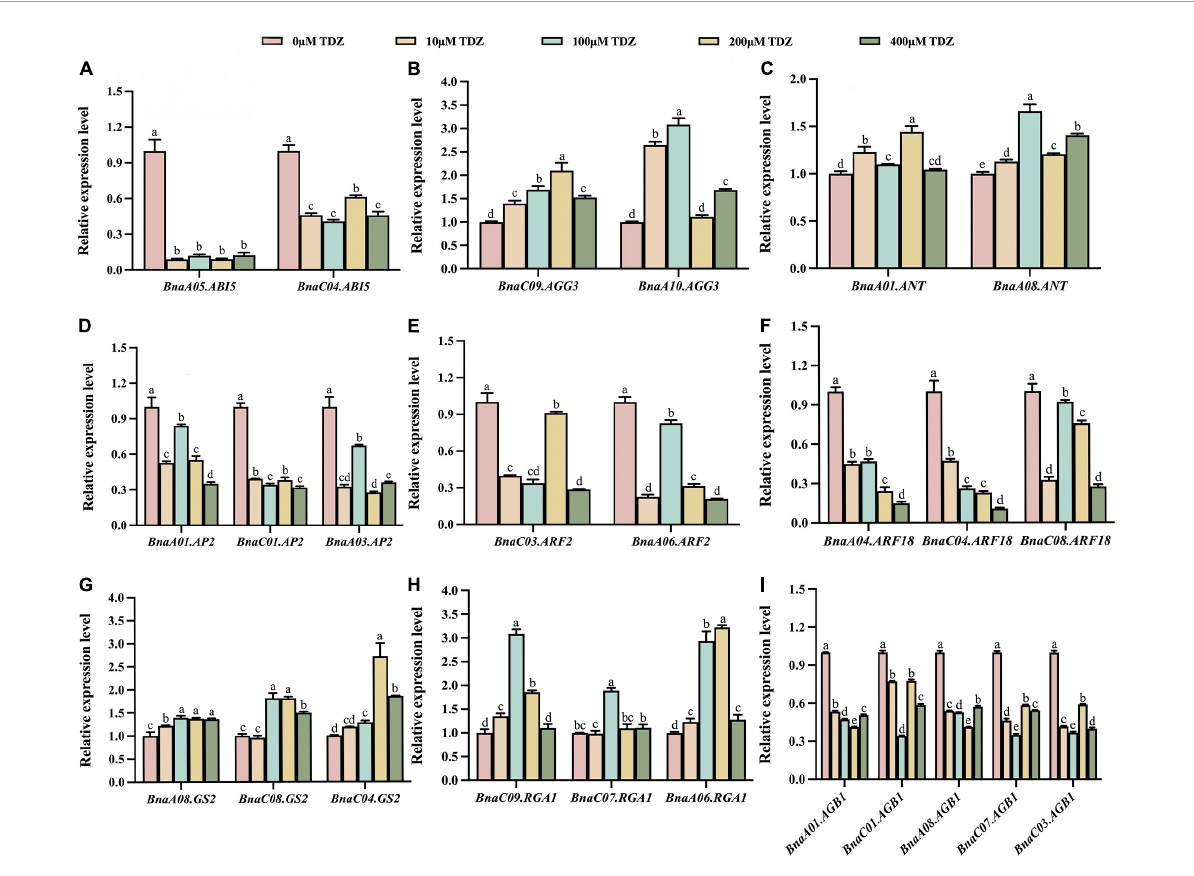
FIGURE5 Relative transcriptional levels of seed size-related genes in buds of B. napus . (A–I) lists the relative transcriptional levels of nine genes associated with seed size located on different chromosomes in buds. Among them, the pink, orange, blue, yellow and green columns represent the relative transcriptional levels of genes in buds treated with 0 µ mol/L, 10 µ mol/L, 100 µ mol/L, 200 µ mol/L and 400 µ mol/L TDZ, respectively. Three biological replicates and three technical replicates were carried out using buds from 3 to 5 days before flowering. Mean ± Standard error ( n = 3). Different letters suggest significant differences (Duncan’s multiple range test, p ≤